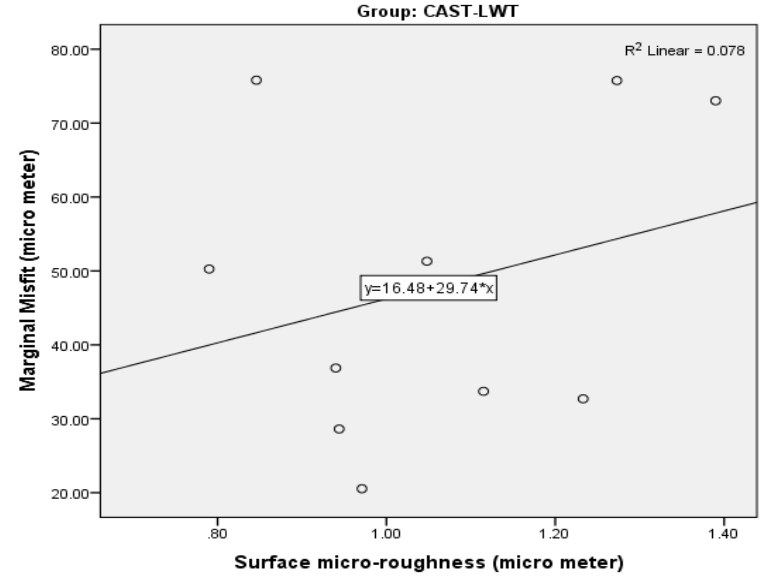
Figure 5. Showing a positive correlation between surface micro roughness and marginal misfit in CAST-LWT samples. R 2 showed 7.8% variation in marginal misfit explained by surface micro roughness; p -value 0.435, and therefore statistically insignificant.